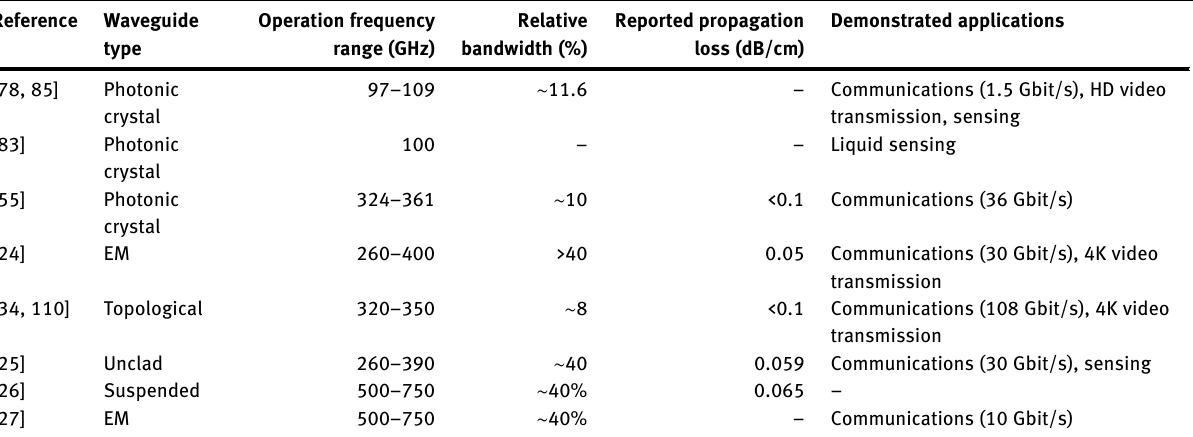
Table  : Comparison of planar all-Si dielectric waveguides.